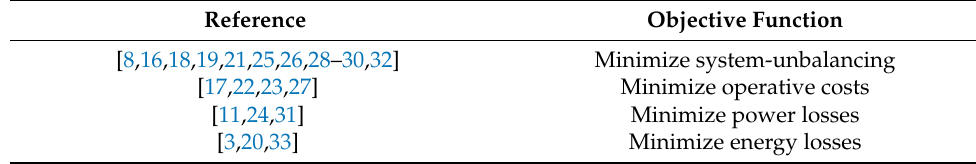
Table 2. Summary of the objective functions presented in the state of the